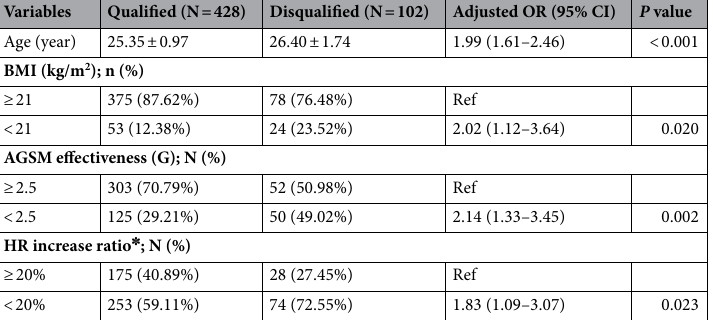
Variables Qualified (N = 428) Disqualified (N = 102) Adjusted OR (95% CI) P value